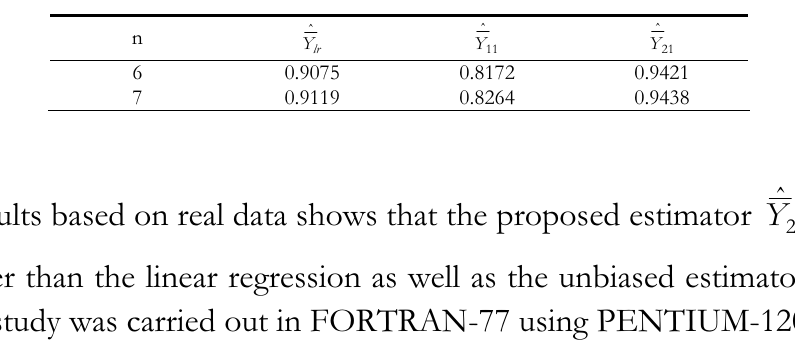
The 95% coverage by three estimators for N=30 and different values of